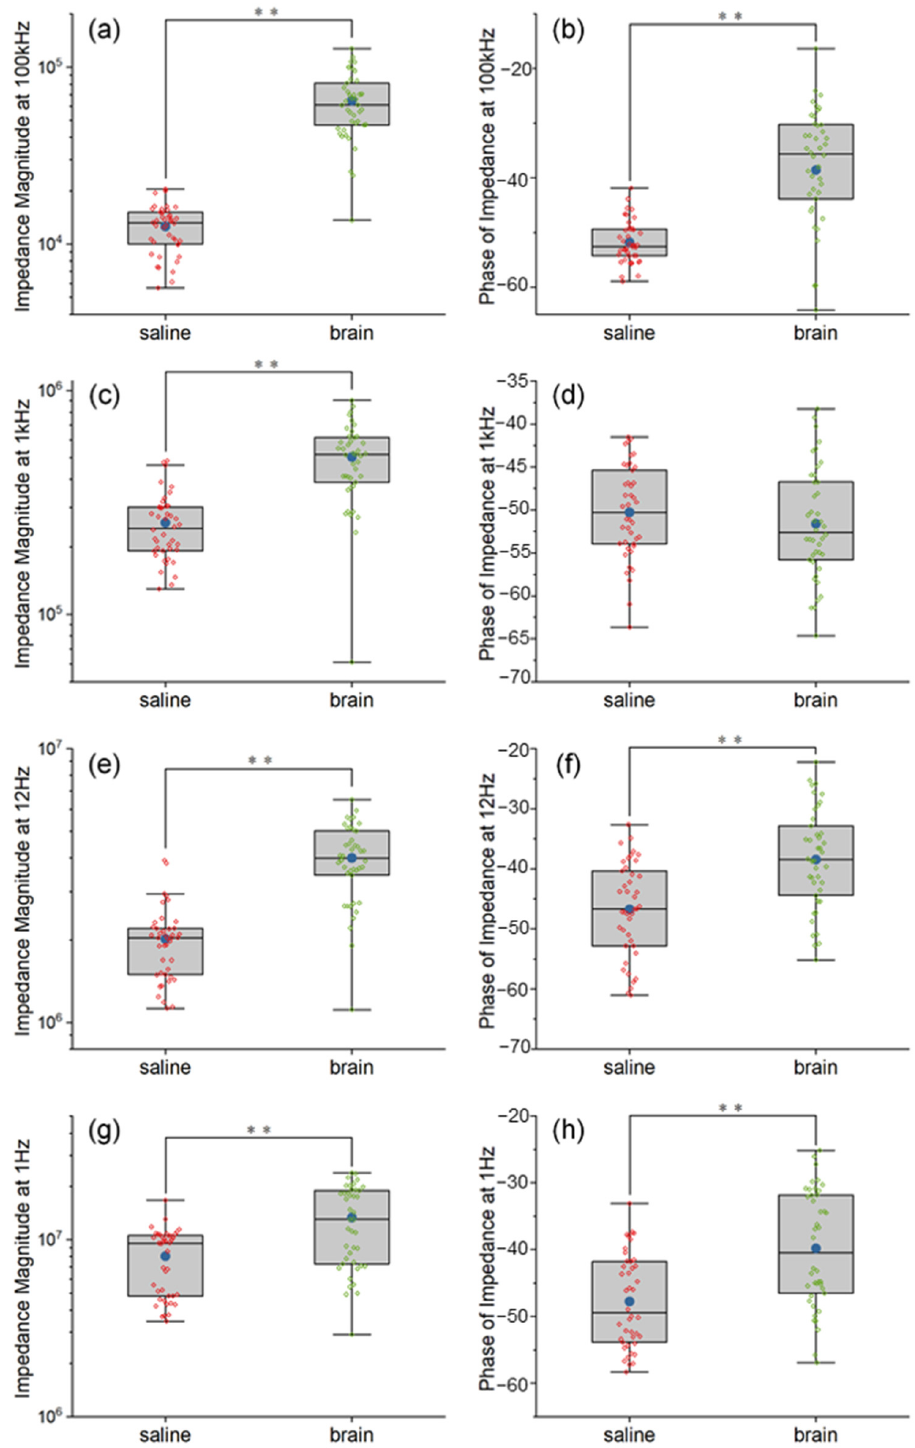
Figure 2. The comparison between the impedance of Pt wire neural electrodes in saline and pig brain in vitro at 100 kHz ( a , b ), 1 kHz ( c , d ), 12 Hz ( e , f ) and 1 Hz ( g , h ). Significance level was set at ** p < 0.01.